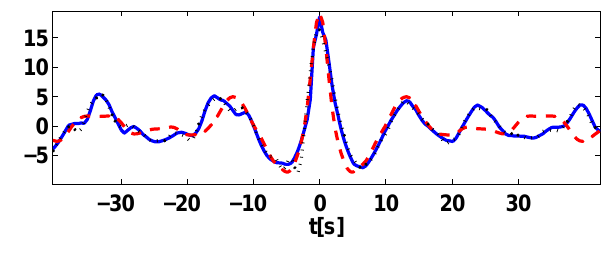
Fig. 13. Draupner Wave (solid), Pm-signal (dashed), and Signal prediction (dotted line) which has been shifted so that the highest peak is at t = 0.